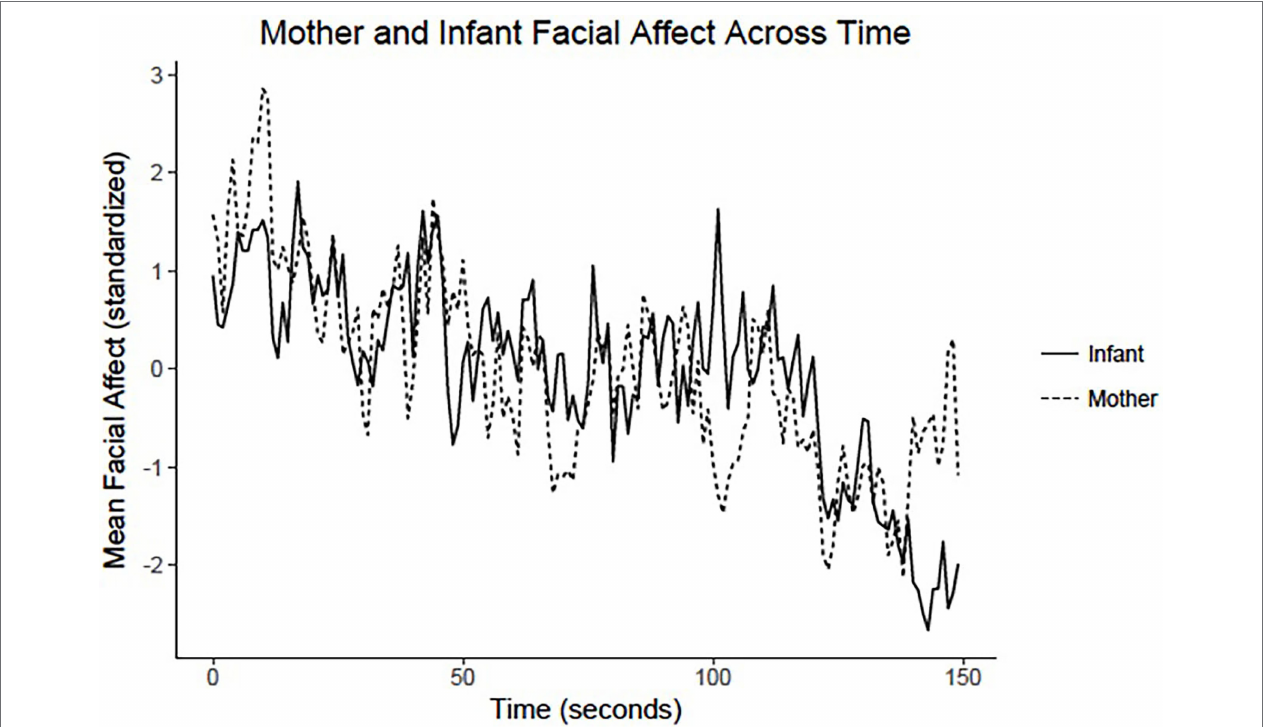
FIGURE 3 | Second-by-second ratings of mother and infant facial affect during sessions (150 s) of mother–infant dyads. This illustration of mothers and infants following the others’ direction of affect change is based on an across-group ( n = 132) documentation of bi-directional contingent coordination via multi-level time- series modeling (Beebe et al., 2016). See text for additional details. Data obtained from Table 1 of Beebe et al.